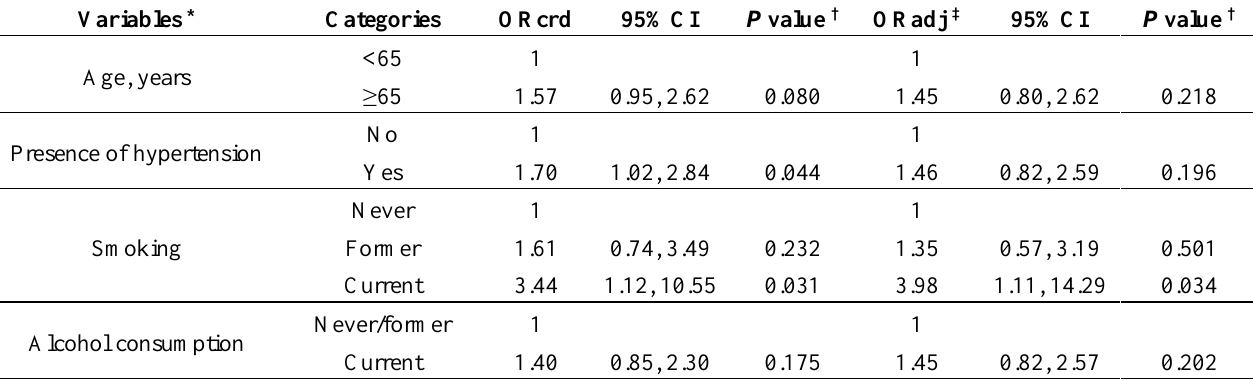
Table 4. Logistic regression analysis with severe periodontitis as dependent